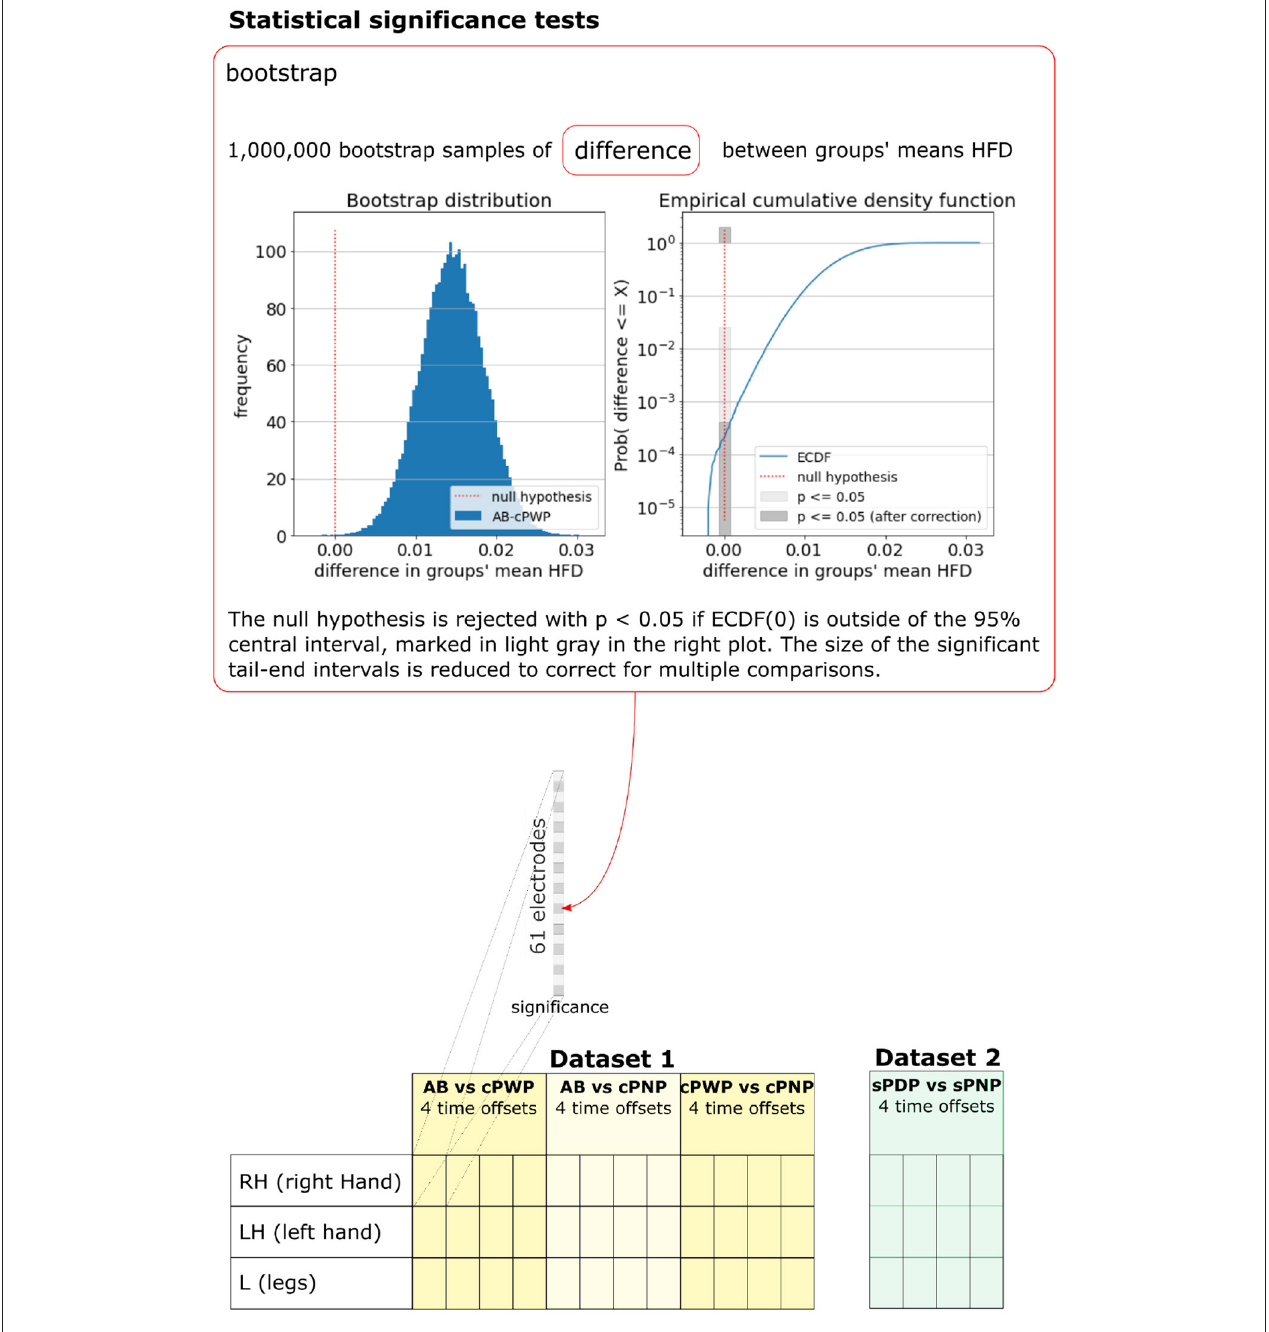
FIGURE 5 | Bootstrap was used to test for statistical significance of differences in group-mean HFD features. The bootstrap sample distribution of differences between groups, the corresponding empirical cumulative density function, and significance thresholds are illustrated for one example pair of groups (AB vs. cPWP), time offset (3 s), MI (RH), and electrode position. A full enumeration of all pairwise differences that were tested is illustrated at the bottom. See section 2.3 for details.